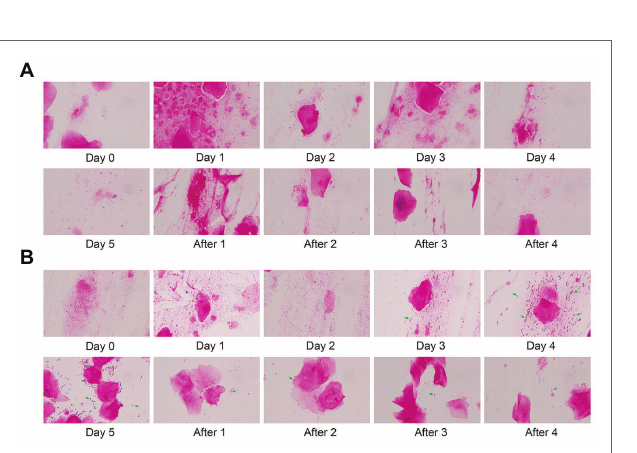
FIGURE 5 | The diversity and abundance of the Lactobacillus during the follow-up of each sample in control and test groups.